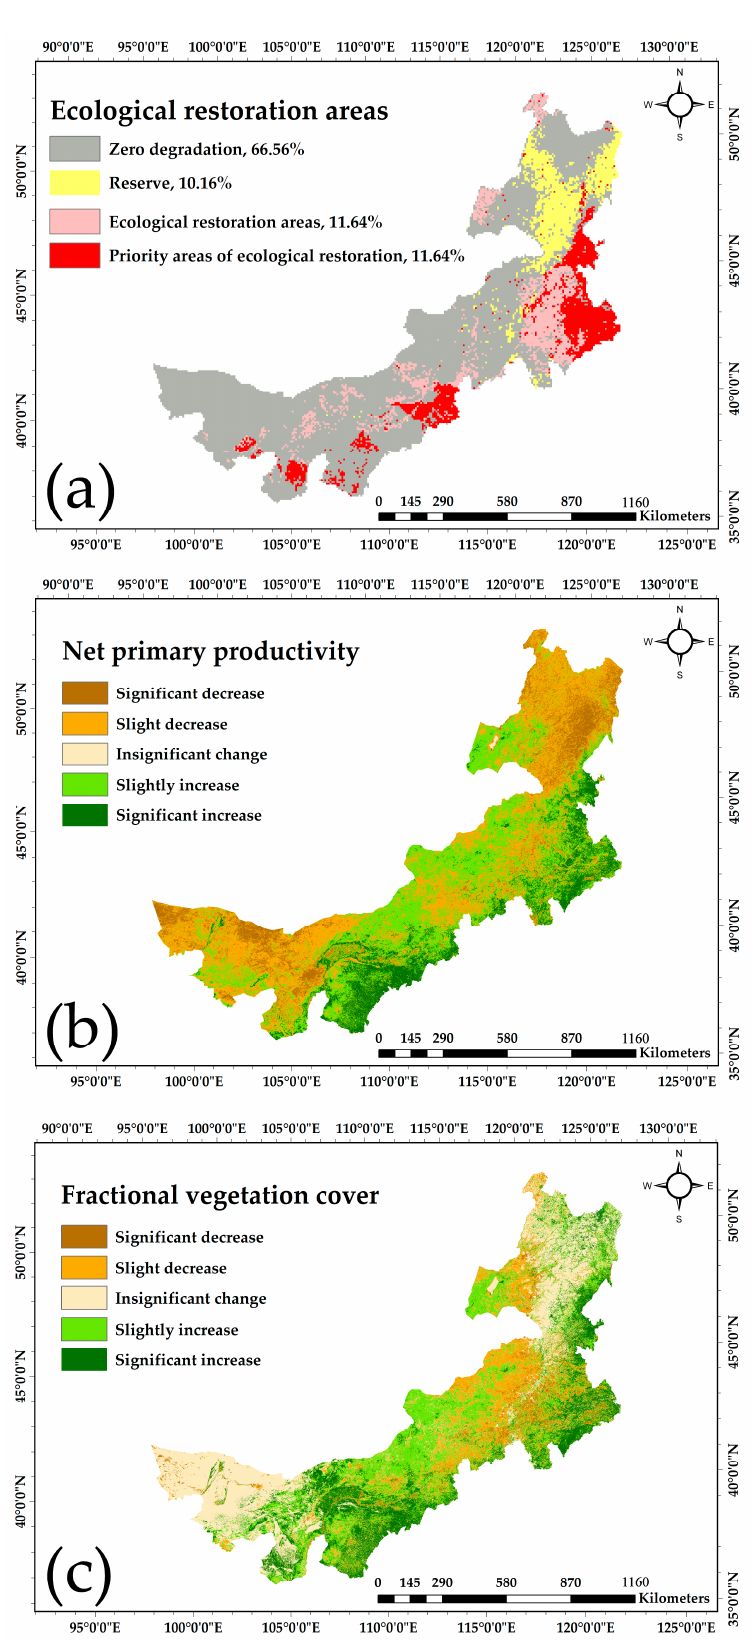
Figure 6. ( a ) Key ecological restoration areas in Inner Mongolia; ( b ) net primary productivity (NPP) change; and ( c ) fractional vegetation cover (FVC)